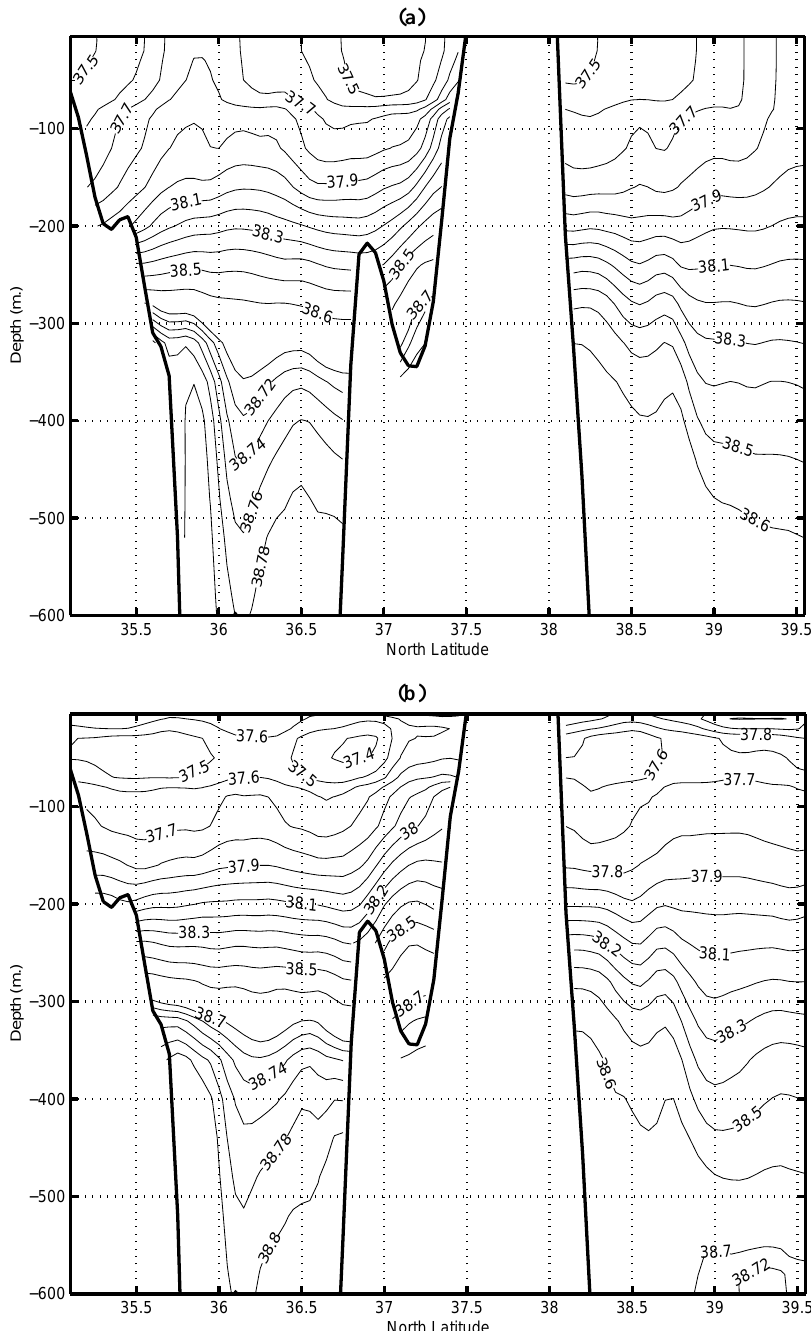
Fig. 15. The simulated 10-day averaged vertical section of salinity along longitude 13 ◦ E in (a) February and (b) August. The contour interval is 0.1psu in the range 37.4 to 38.7psu, and 0.02psu in the range from 38.7 to